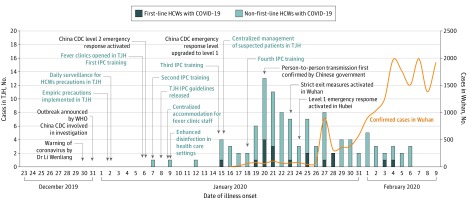
Change of Daily Infected Numbers of Health Care Workers (HCWs) With Coronavirus Disease 2019 (COVID-19) in Tongji Hospital (TJH)Daily numbers of HCWs who were infected with severe acute respiratory syndrome coronavirus 2 (SARS-CoV-2) in TJH by date of illness onset. The decline in incidence after January 20 is likely because of a risk-stratified strategy of prevention and control. China CDC indicates Chinese Center for Disease Control and Prevention; and IPC, infection and protection control.